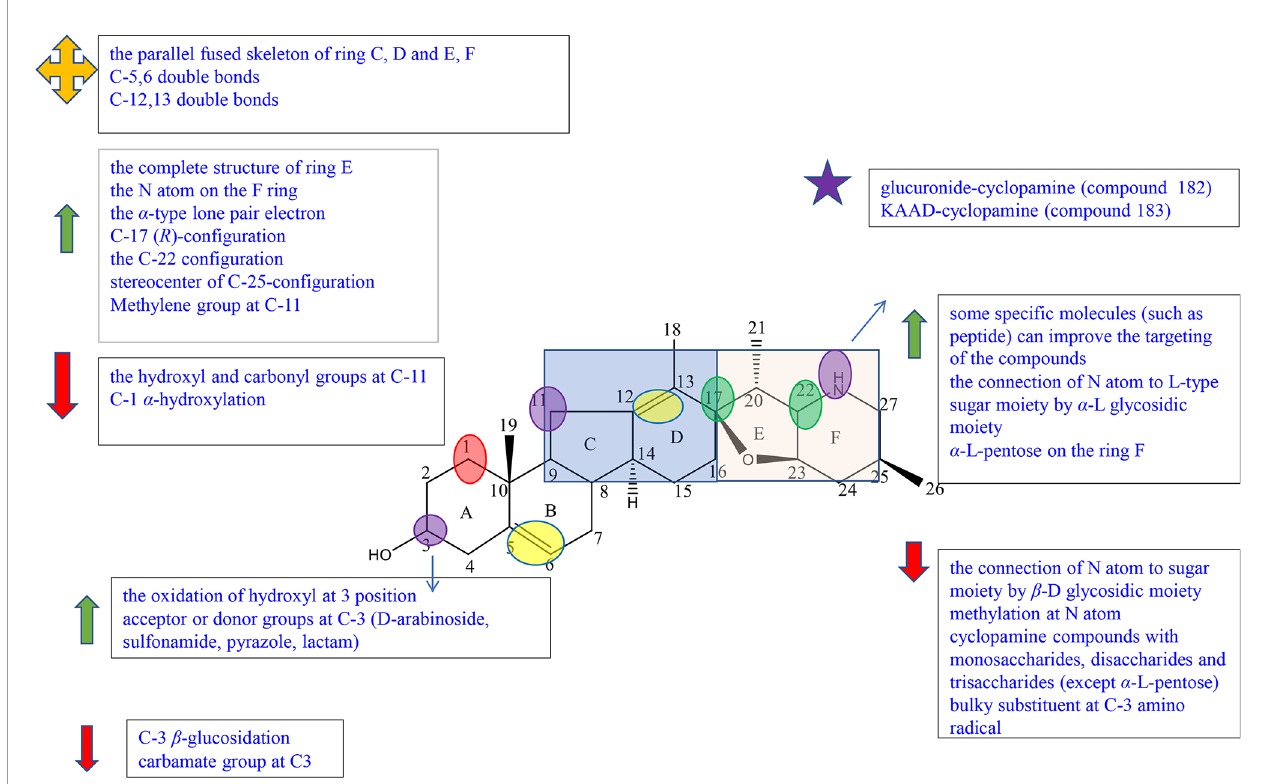
FIGURE 6 | Summary of Structure-activity Relationship of